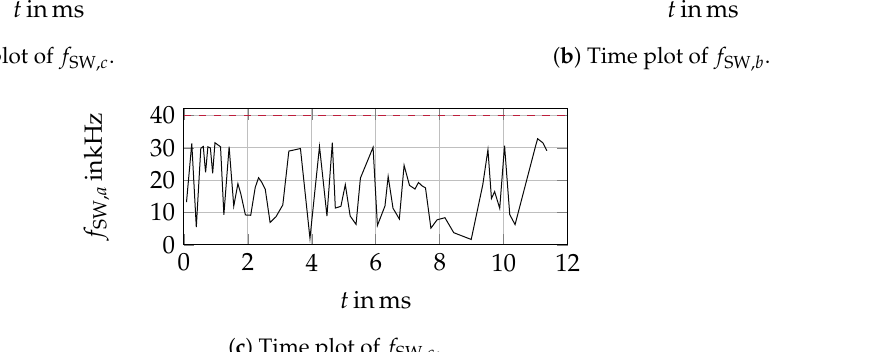
( a ) Time plot of f SW, c . ( b ) Time plot of f SW, b .